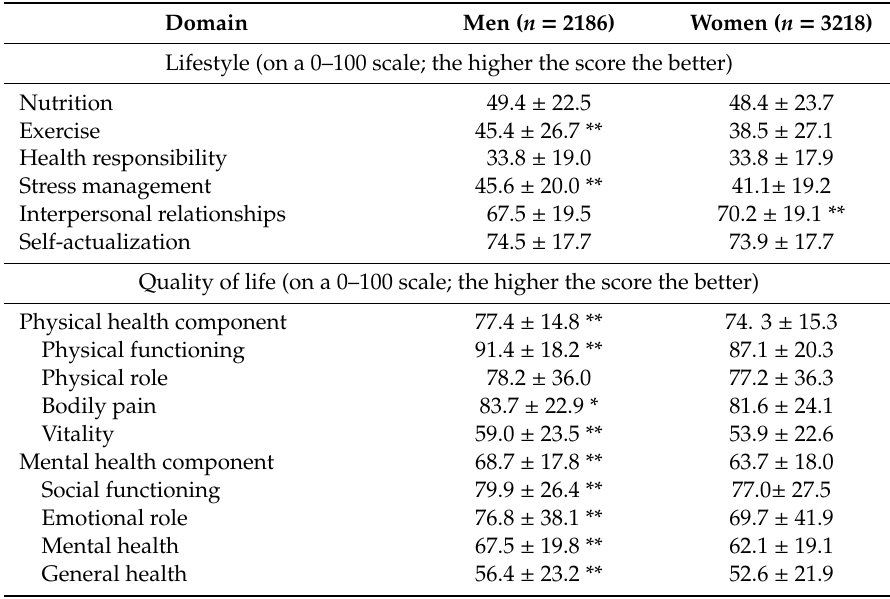
Table 1. Lifestyle and Quality of Life in University Students, Stratified by Sex ( N =